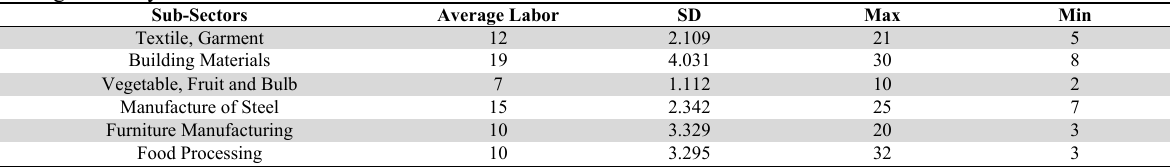
Average labor by Sub-sectors Unit: Labors